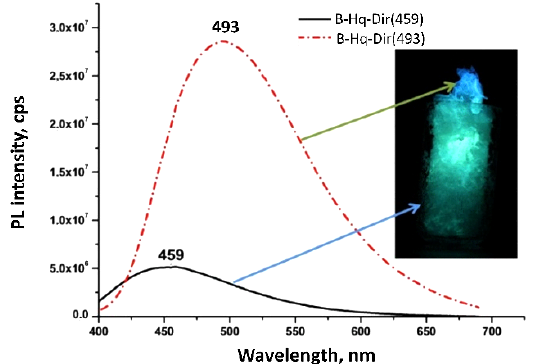
Figure 6. PL spectra of BLC obtained by heterophase synthesis.